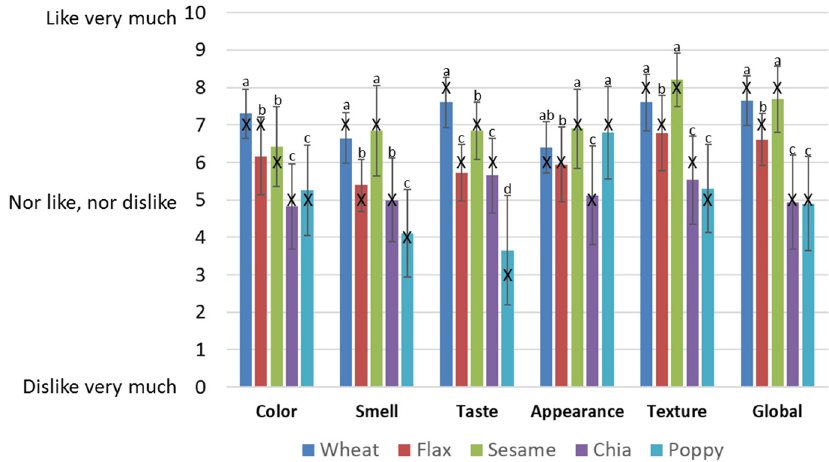
Figure 3. Sensory properties of cookies elaborated with defatted seed flours. Different letters in the same column indicate significant differences ( p < 0.05). same column indicate significant differences ( p <